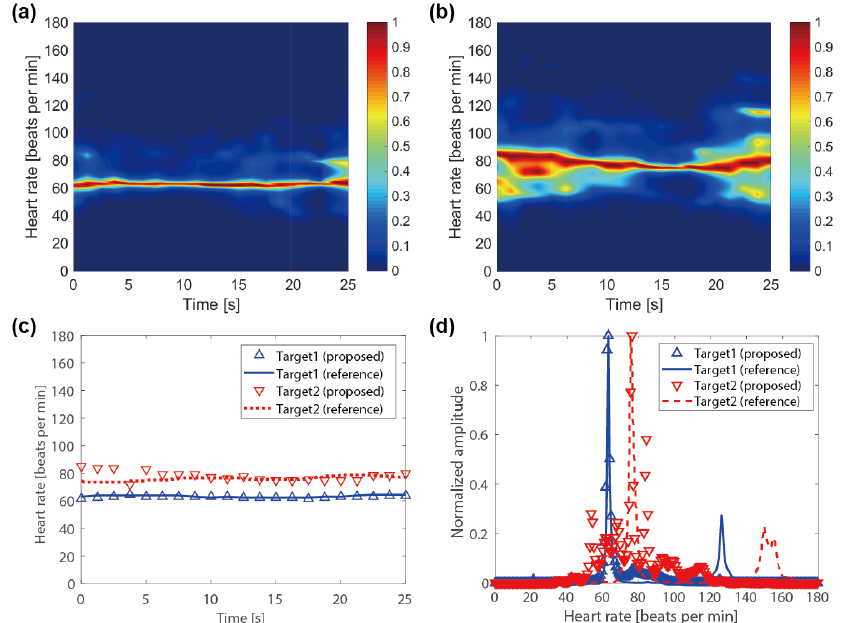
Figure 12. Compensated measurement results for two targets with the range integration: ( a ) real-time heart rate for the front target at a distance of 130 cm; ( b ) real-time heart rate for the rear target at a distance of 170 cm; ( c ) comparison between the proposed method and the reference sensor in terms of the real-time data; and ( d ) comparison between the proposed method and the reference sensor in terms of the total time.